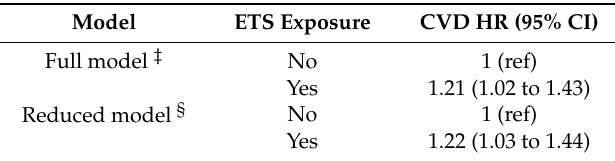
Table 2. Exposure to environmental tobacco smoke (ETS) and CVD incidence among nonsmokers, Strong Heart Study ( n = 1843).